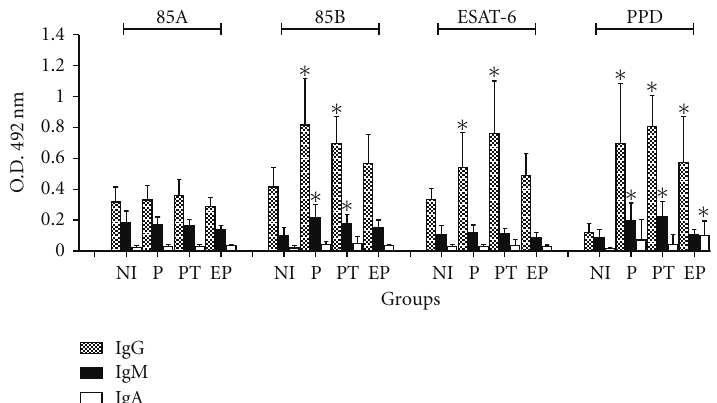
Figure 1: Levels of serum IgG (hatched box), IgM (black box) and IgA (empty box) to Ag85A, Ag85B, ESAT-6, and PPD were determined in serum of non-infected individuals (NI), pulmonary tuberculosis patients (P), pulmonary tuberculosis patients undergoing treatment (PT) and extra-pulmonary tuberculosis (EP). Results are presented as mean ± standard deviation. Di ff erences between responses from TB patient groups and control groups were analyzed with nonparametric Kruskall-Wallis test. ∗ Statistically significant di ff erences in relation to NI group ( P < .